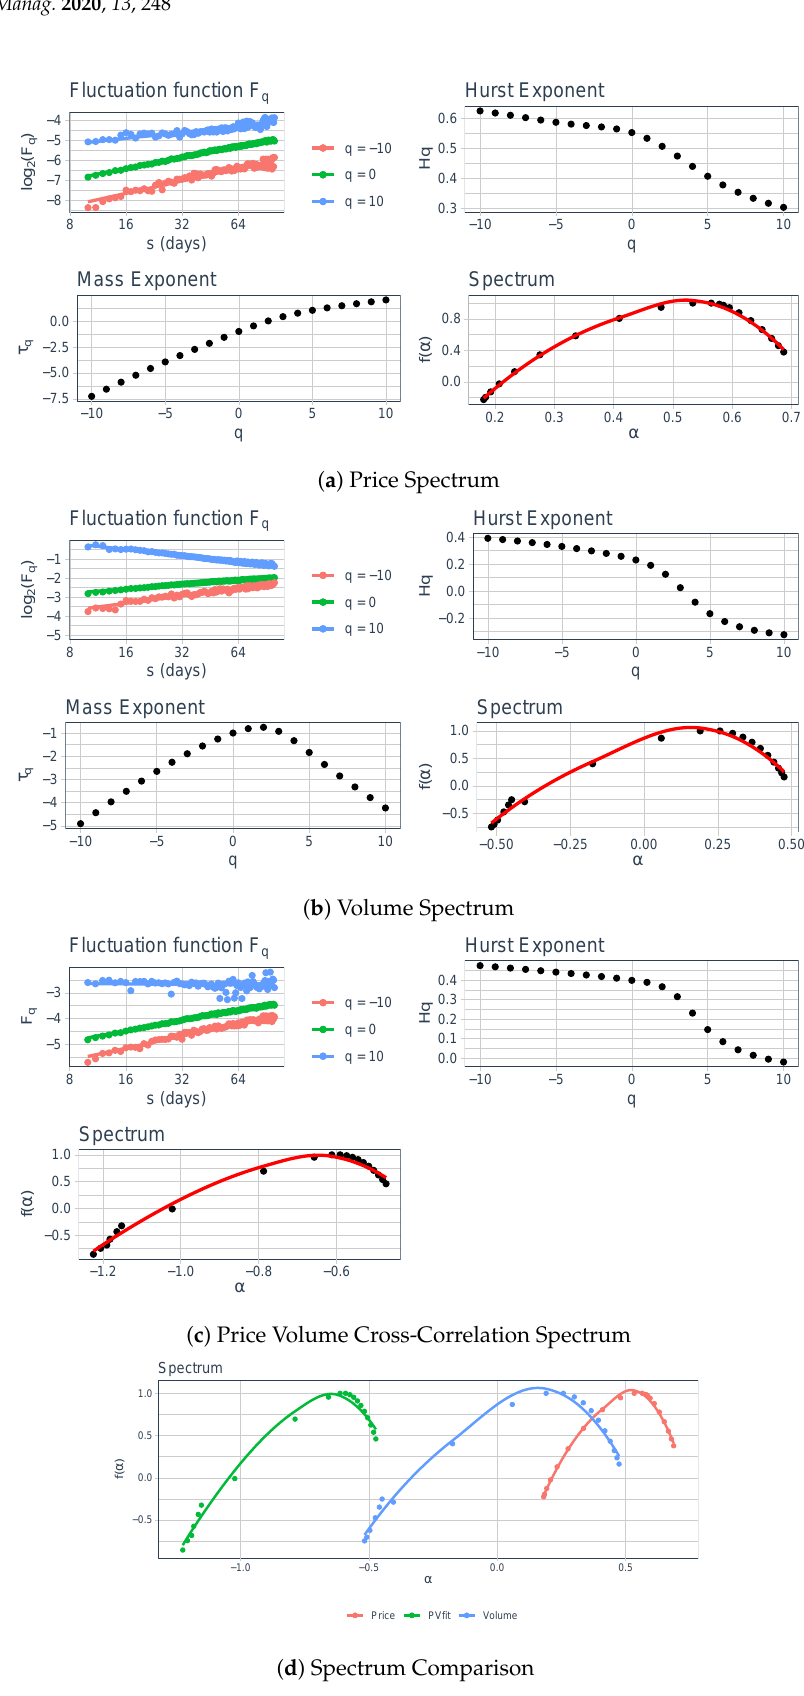
Figure 4. Whole data price, volume, and price-volume cross-correlation